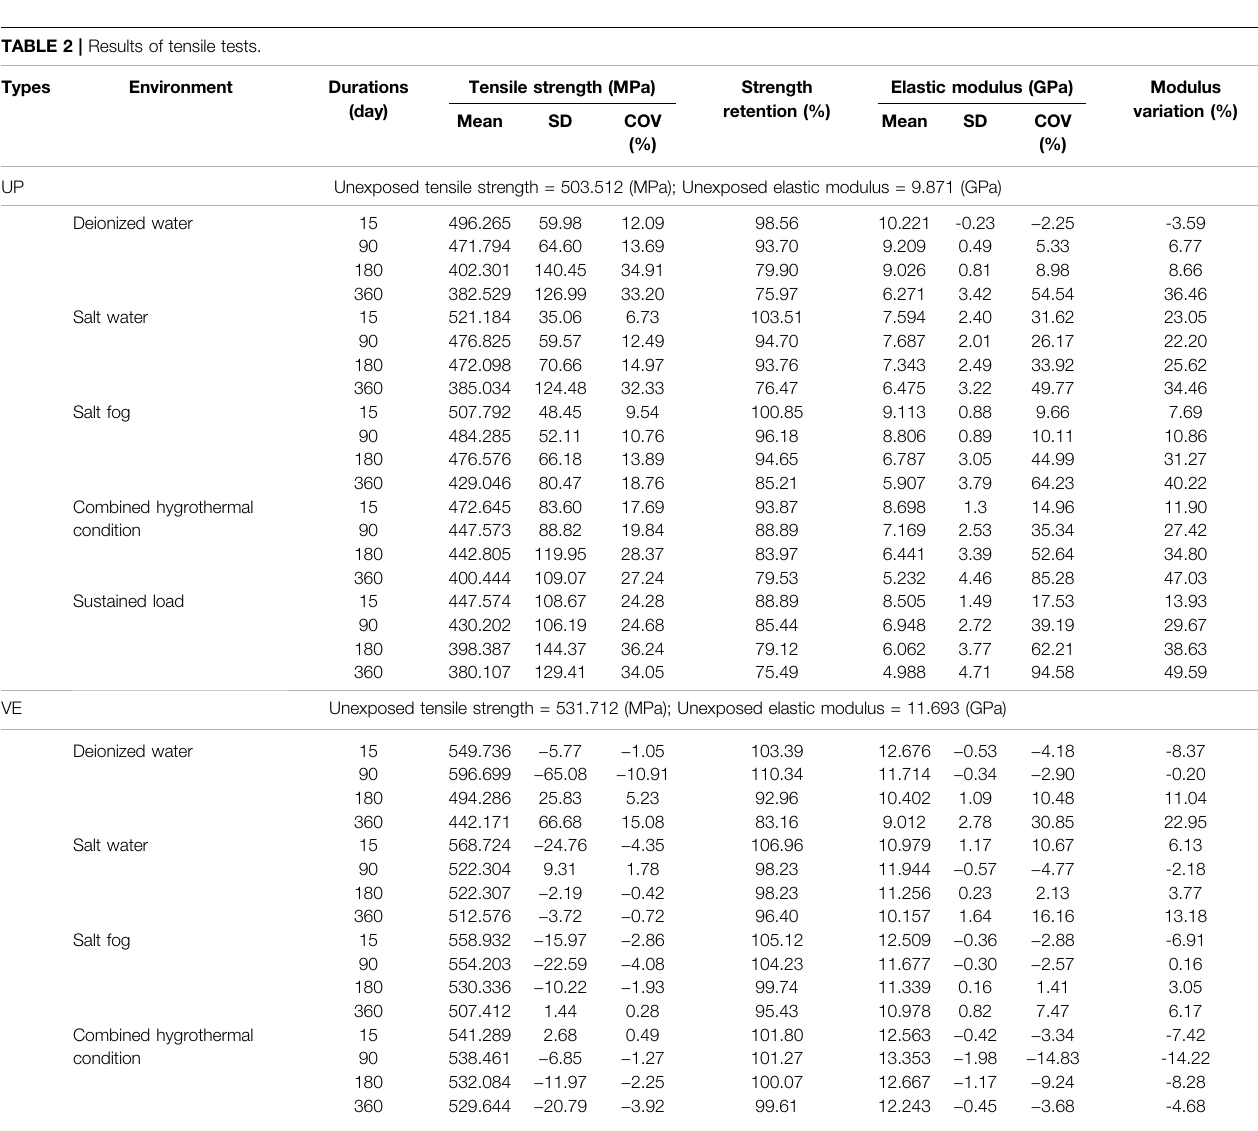
TABLE 2 | Results of tensile